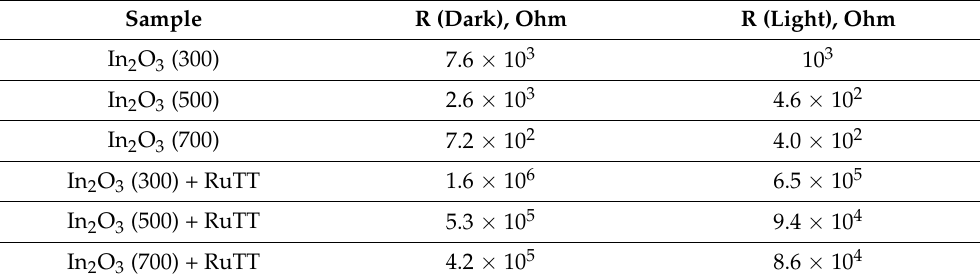
Table 6. Baseline resistance in dark conditions and under LED illumination in dry air at room